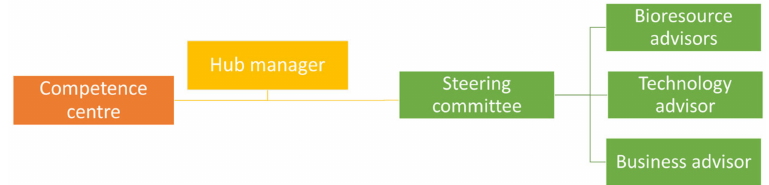
Figure 2. DIH general